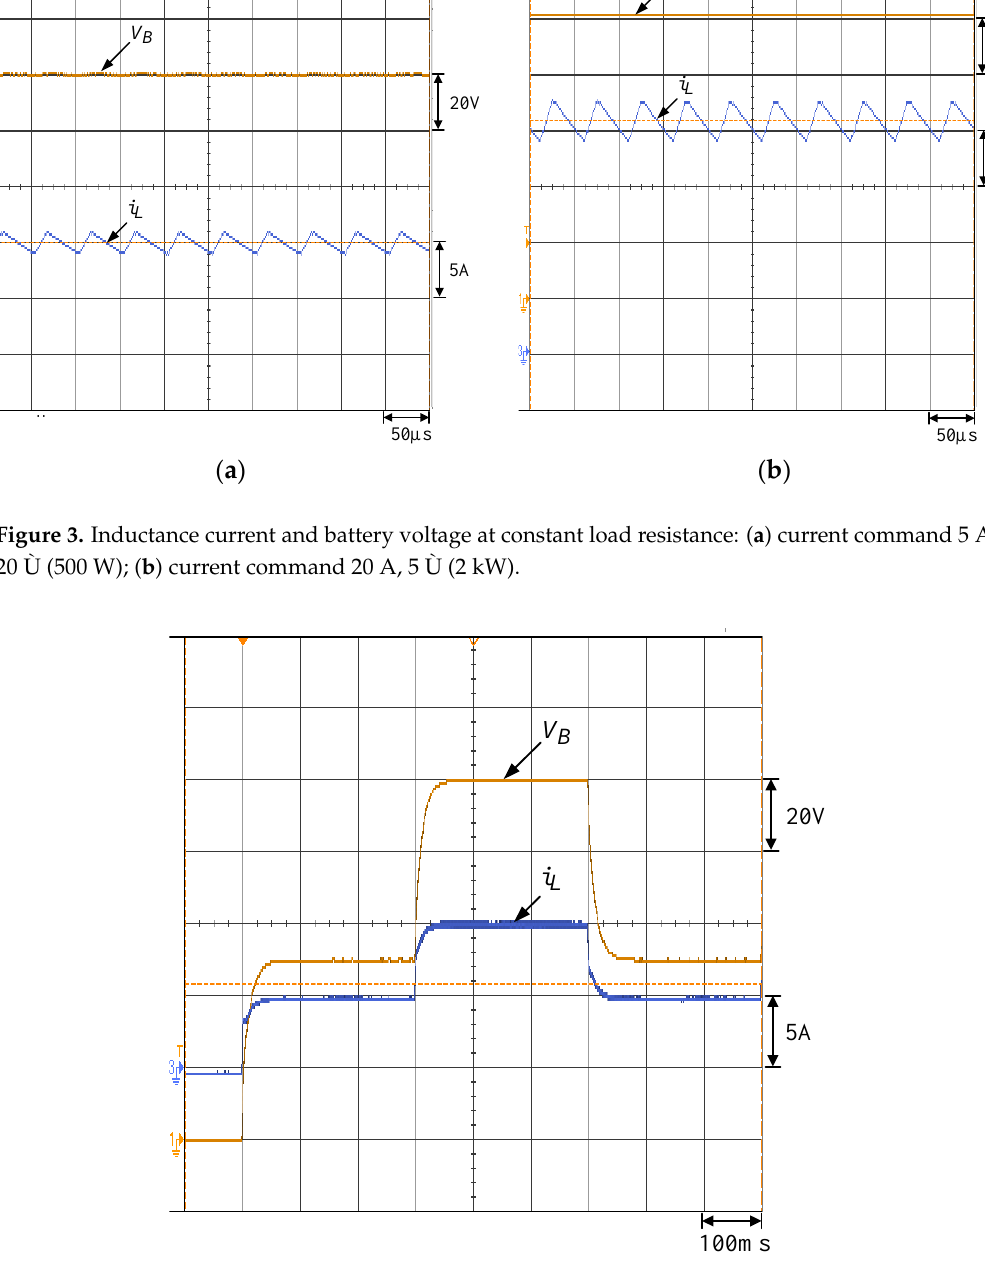
Figure 4. Inductance current and battery voltage with current command variation 5 A → 10 A → 5 A (load 10 Ù ).